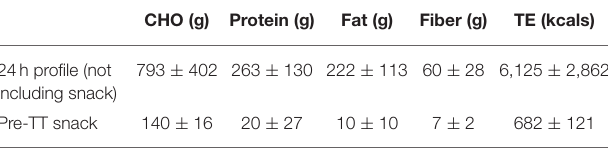
TABLE 2 | Reliability data [Intraclass Correlation Coefficients (ICC), Confidence Intervals (CI), and Typical Error of the Measurement (TEM)] collected during